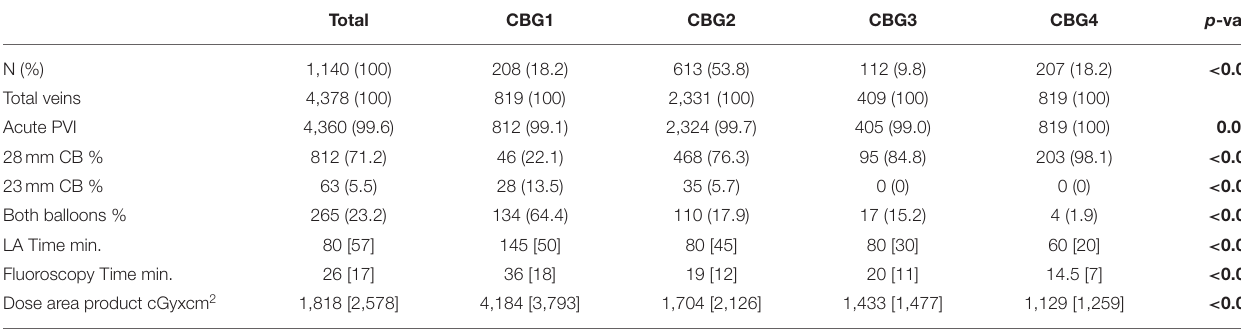
TABLE 2 | Procedural characteristics and differences in the treatment groups.